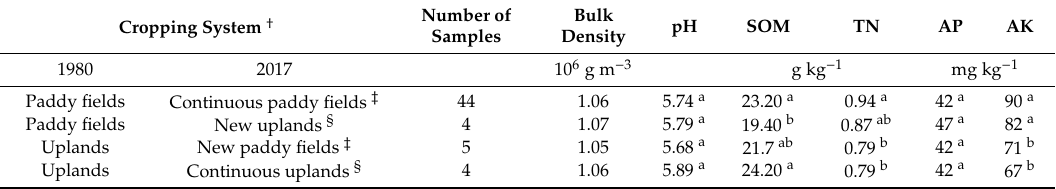
Table 3. Topsoil attributes in the cropping systems identified as of 2017.